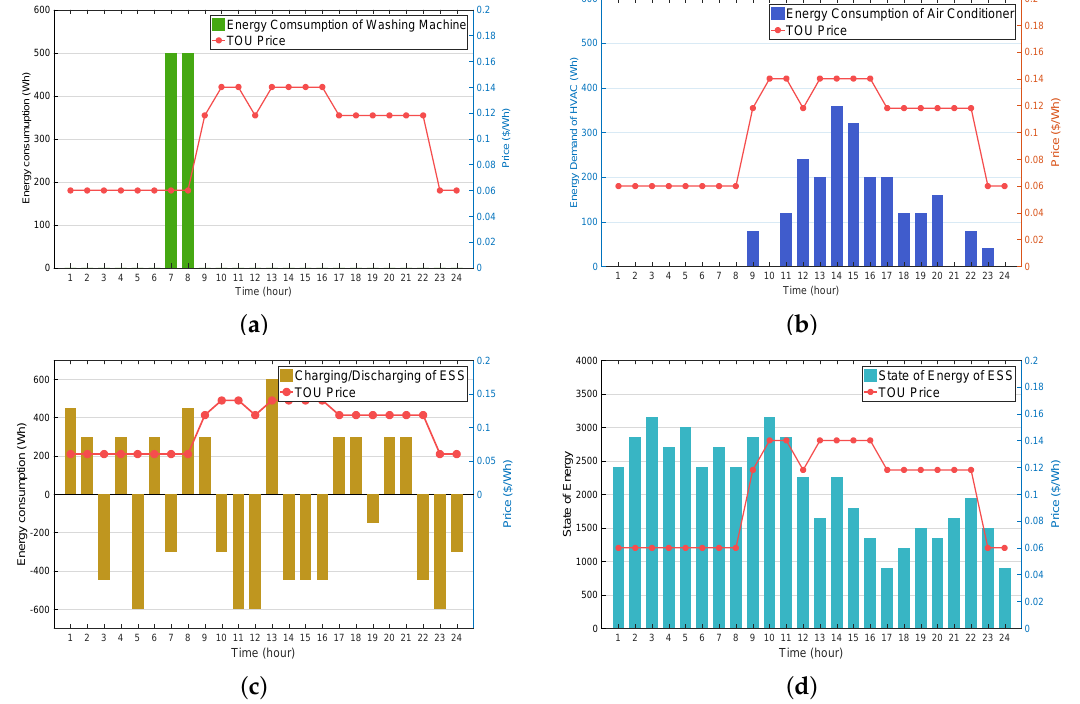
Figure 6. RL-based day-ahead operating schedule of appliance under TOU pricing tariff. ( a ) energy consumption of washing machine (WM); ( b ) energy consumption of air conditioner (AC); ( c ) charging and discharging of energy storage system (ESS); ( d ) state of energy (SOE) of